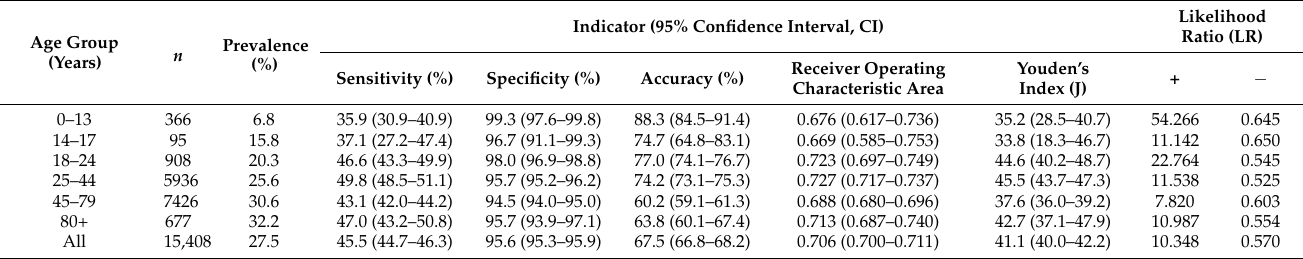
Table 1. Performance of antigen-based tests in the diagnosis of coronavirus disease 2019, Mexico